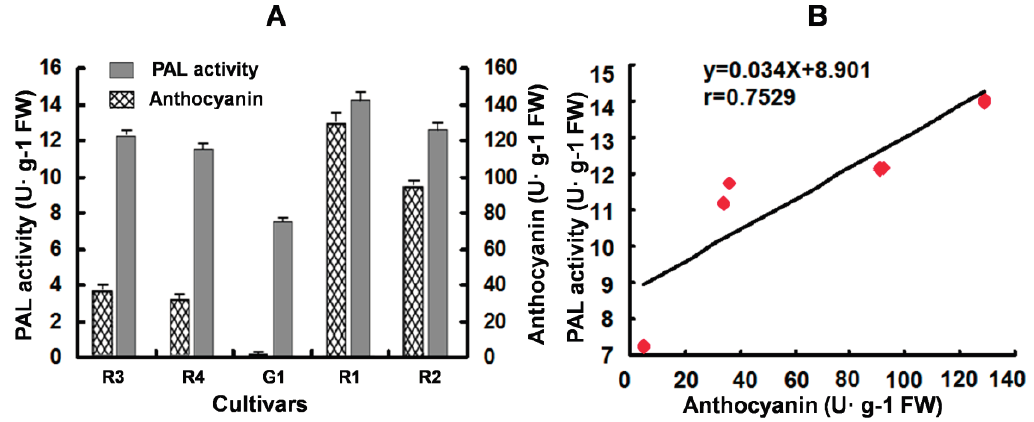
Figure 10. Analysis of PAL activity and anthocyanins concentration ( A ) and their correlation analysis ( B ) in the leaves of five Coleus cultivars. Each datum represents the average of three experiments (±SD) in (A). R1, R2, R3, R4 and G1 are different cultivars explained in Section